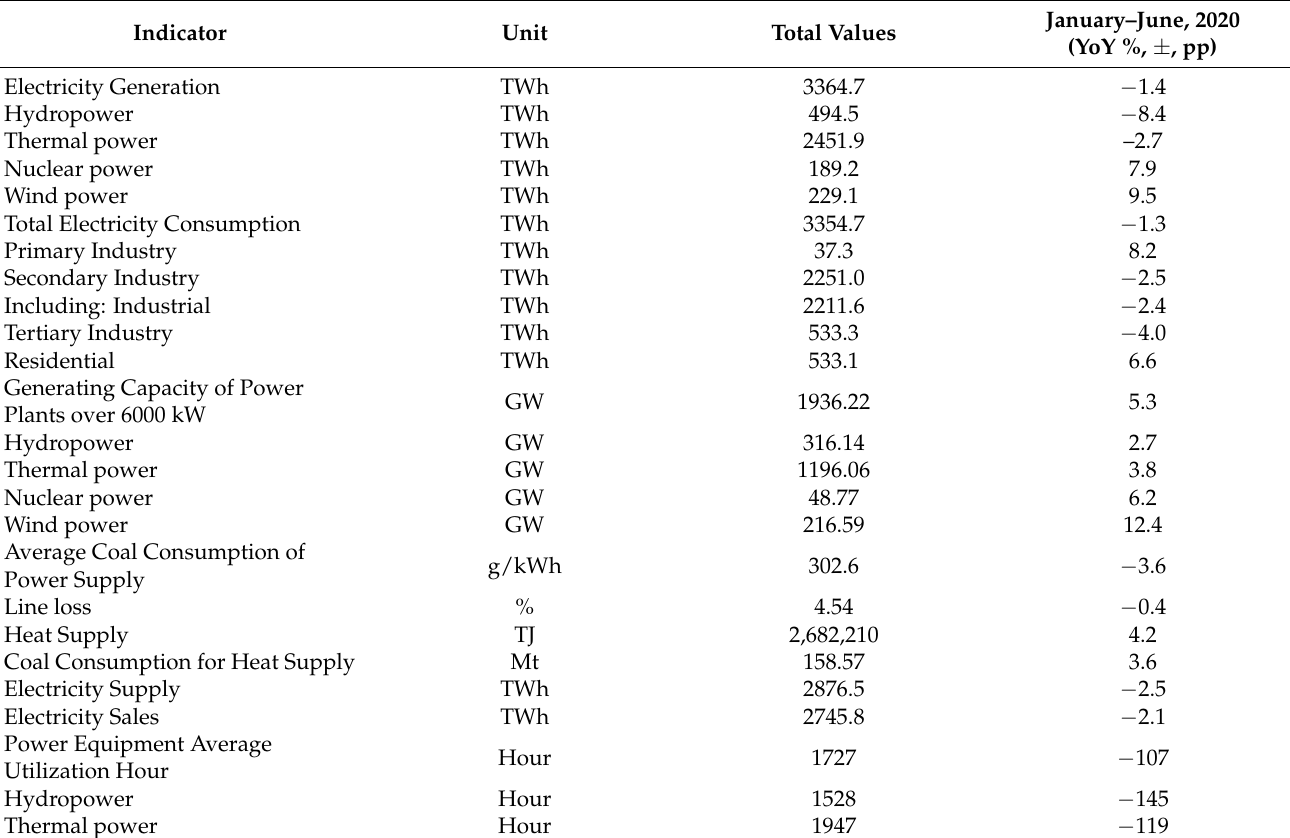
Table 4. China’s power sector statistics for the first two-quarters of January to June 2020 [45]. Source: CEC (2020) Statistics of China Power Industry. All rights